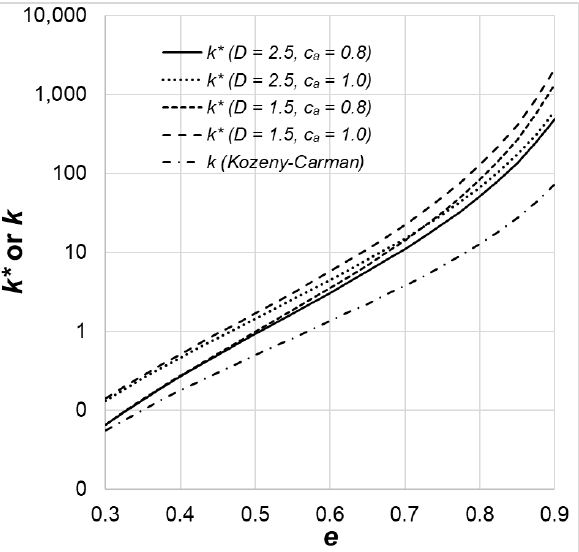
Figure 3. The mean dimensionless permeability k* versus the porosity e for a few selected values of the fractal parameters. The k result from the KC equation is also plotted for comparison.